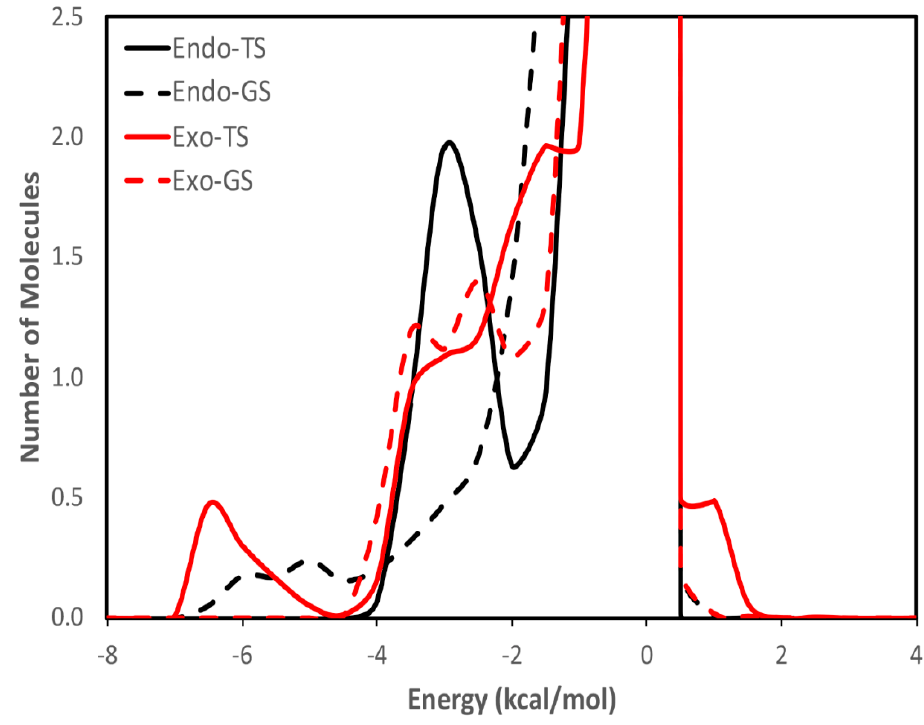
Figure 2. Solute-solvent energy pair distributions for the Diels-Alder reaction between cyclopentadiene and methyl acrylate for the reactants (GS) and transition state (TS) in [BMIM][PF 6 ] at 25 °C using the OPLS-VSIL force field. The ordinate provides the number of solvent ions that interact with the solutes and their interaction energy on the abscissa. Units for ordinate are number of molecules per kcal/mol.